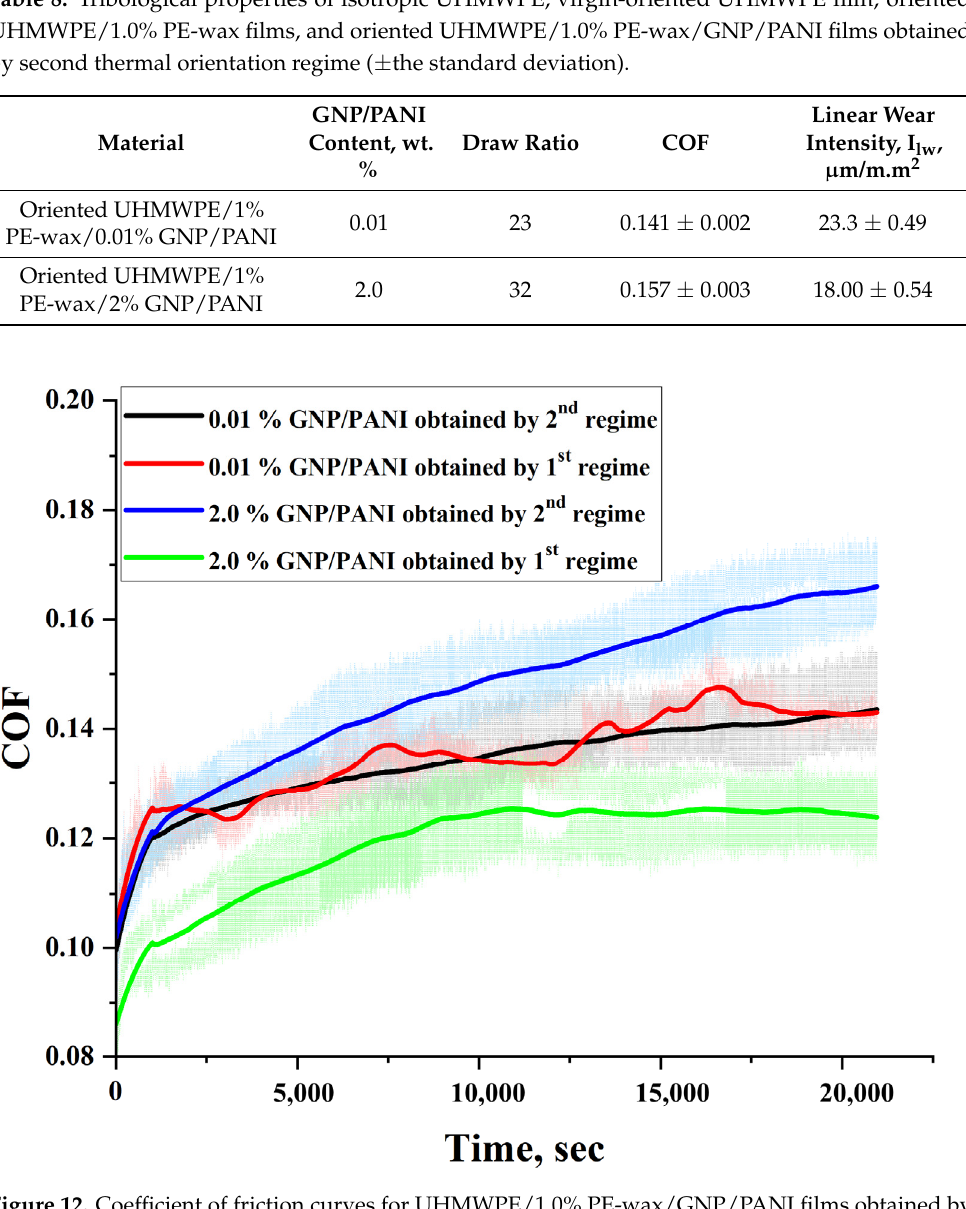
Figure 13. Linear wear intensity for UHMWPE/1.0% PE-wax/GNP/PANI films obtained by second thermal orientation regime in comparison with the films obtained by the second regime.